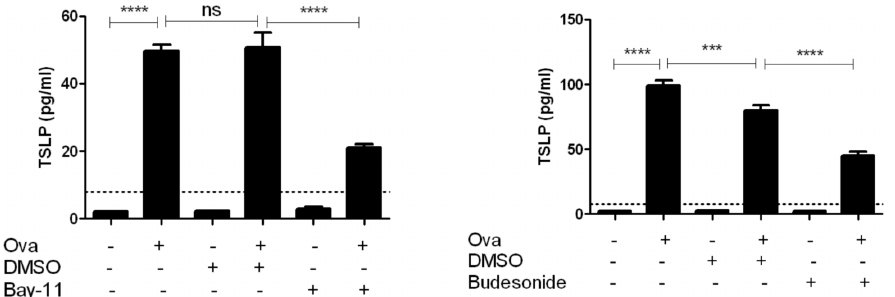
Fig 5. OVA-Induced esophageal epithelial TSLP induction is dependent upon NF-kB signaling and inhibited by budesonide in vitro . A ) differentiated EPC2-hTERT cells were pre-incubated with Bay-11 for 1hr prior to stimulation with OVA. TSLP in culture supernatant was assayed after 24 hrs. B ) Differentiated EPC2-hTERT cells were stimulated with Ova in the presence or absence of budesonide (1uM) or DMSO (vehicle) for 24hrs.TSLP in culture supernatant was assayed using ELISA. *** p < 0.001, **** p < 0.0001, NS = not